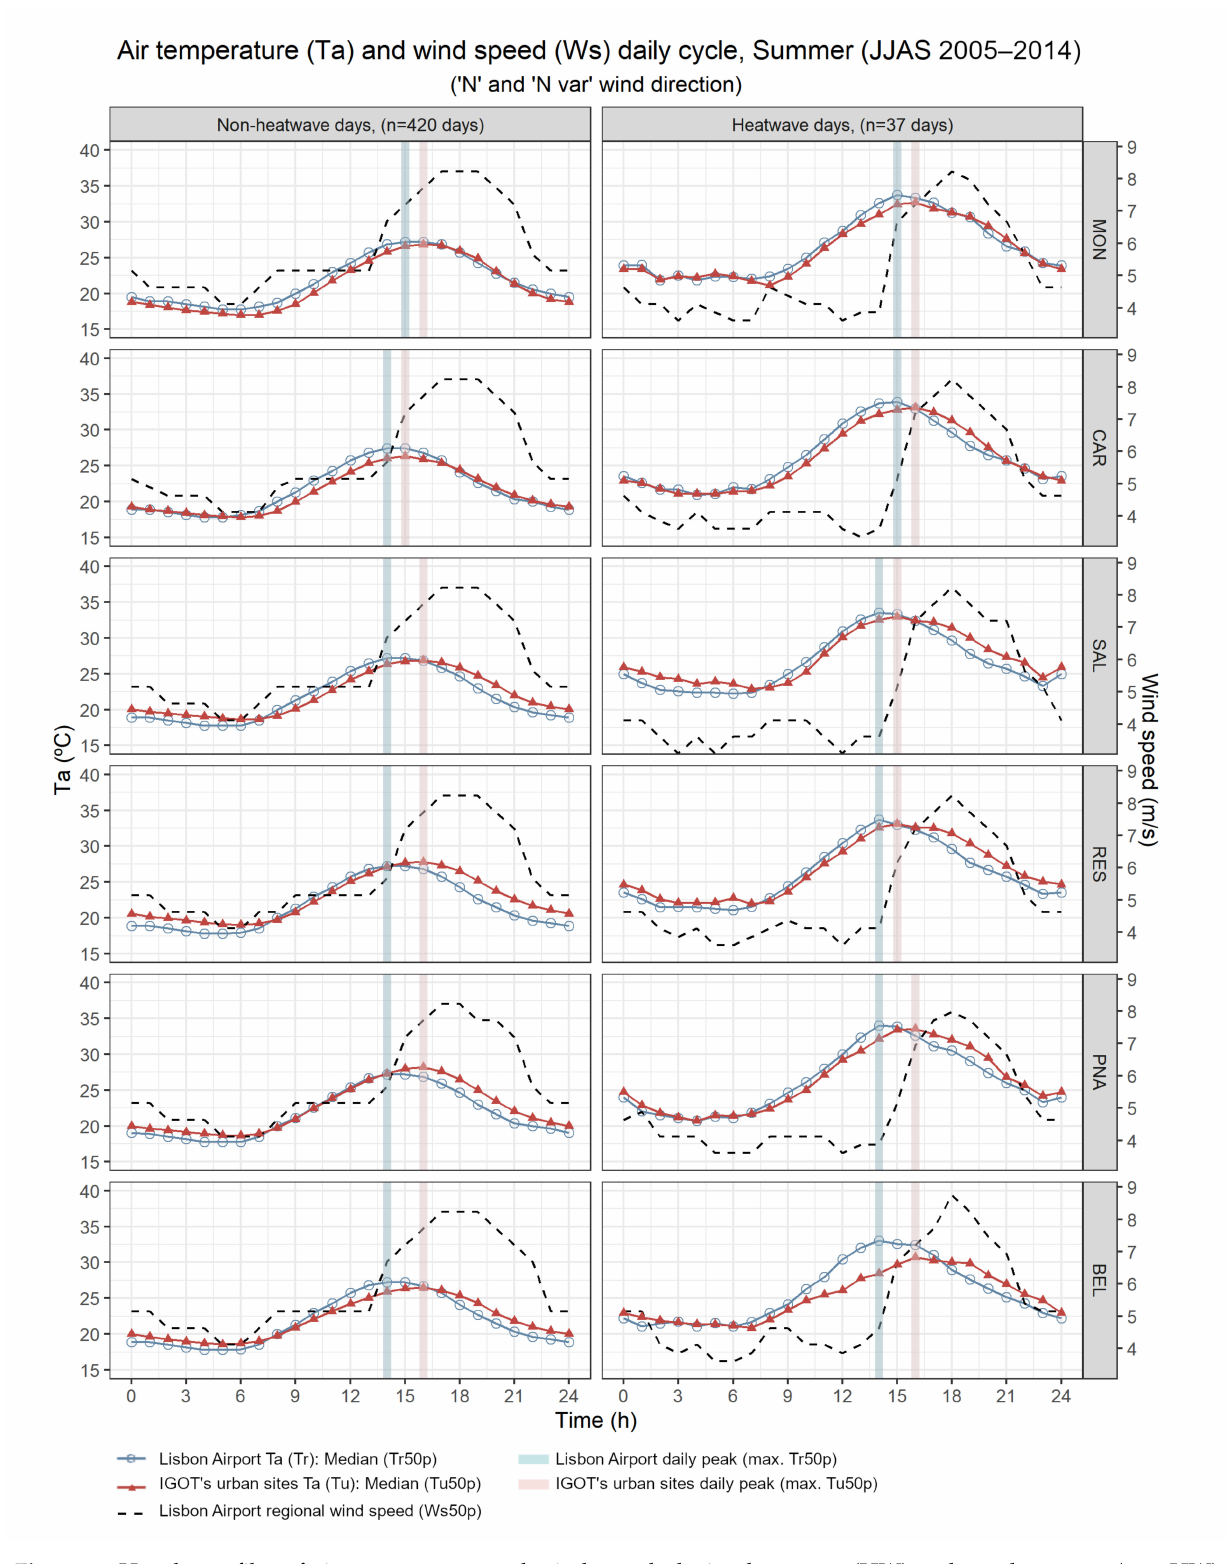
Figure 4. Hourly profiles of air temperatures and wind speed, during heatwave (HW) and non-heatwave (non-HW) conditions: median air temperature at Lisbon Airport, Tr (Tr50p), median urban air temperatures, Tu (Tu50p), and median wind speed (Ws50p) at Lisbon